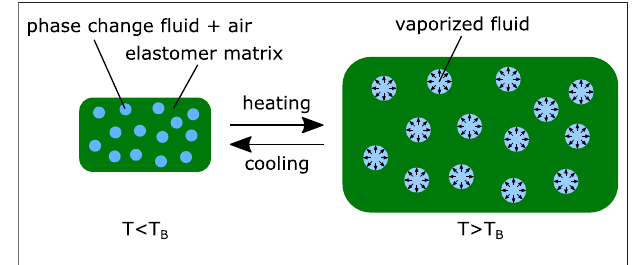
FIGURE 1 | PCMEC actuation